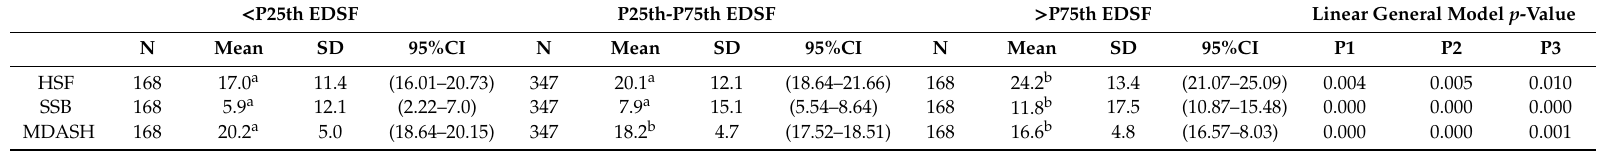
Table 3. Food group consumption by quartiles of frequency of consumption of energy dense salty food.